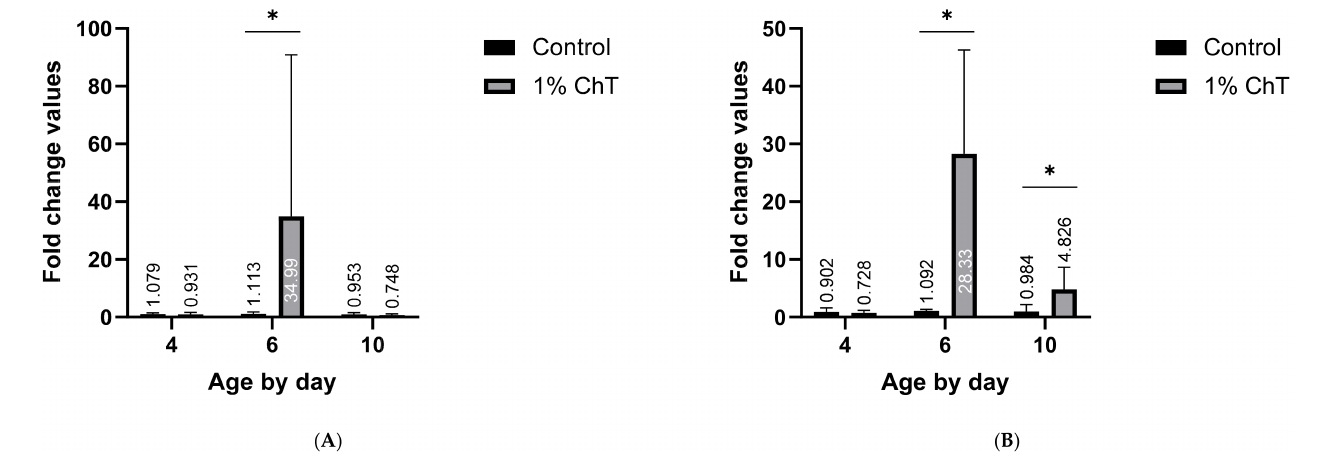
Figure 1. ( A , B ) IL-6 mRNA expression of cecal tissue from experimental chicks fed 1% ChT inclusion diet, determined by quantitative RT-PCR: ( A ) First experimental fold changes by age tested comparison of averaged 1% ChT inclusion group with control group; ( B ) Second experimental fold changes by age tested comparison of averaged 1% ChT inclusion group with control group. * = significantly different from the controls ( p ≤